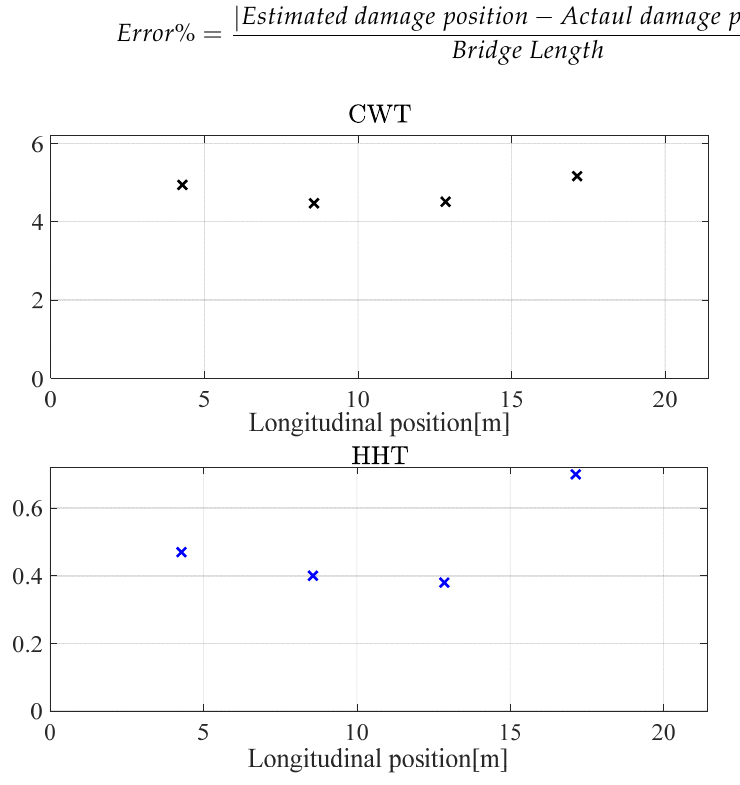
Figure 18. Trend of coefficients maximum magnitudes as function of damage position. CSA train travelling at 100 km/h, and no track irregularity.